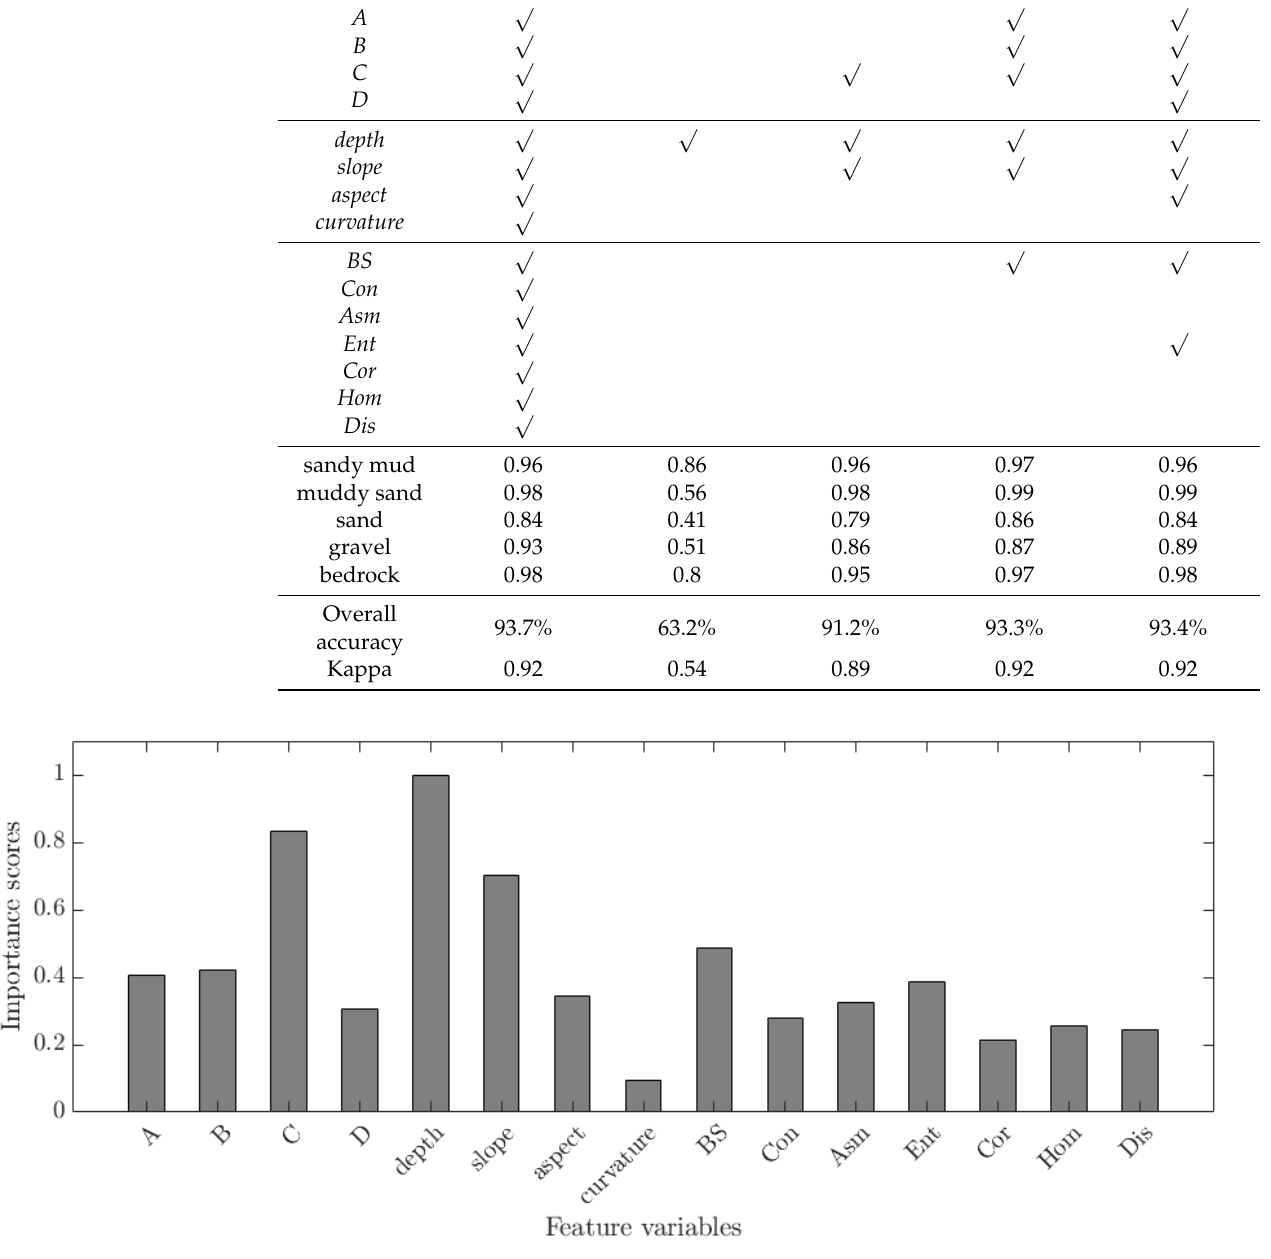
Figure 8. The importance score of features. Table 2. Feature sets of different models and classification performance.